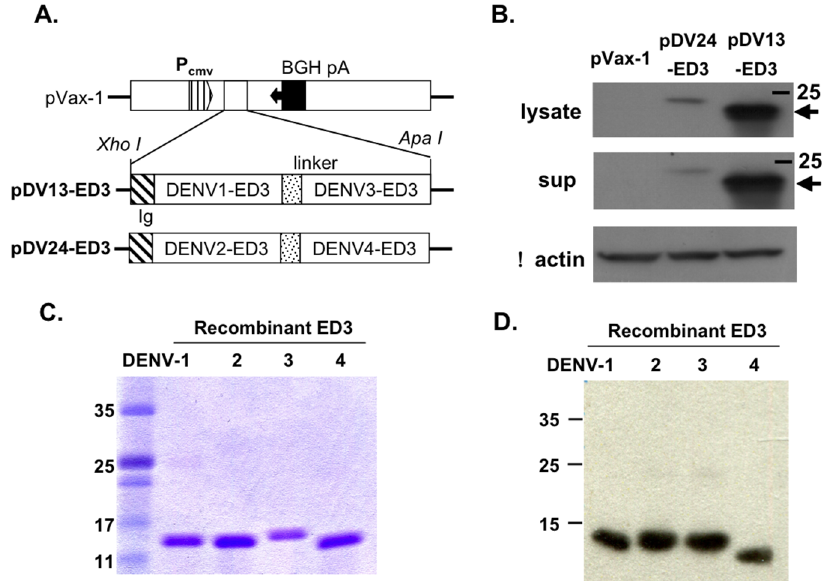
Fig 1. Preparation of a tetravalent ED3-expressing DNA vaccine and a tetravalent recombinant ED3 protein vaccine. (A) Schematic diagram of two ED3-expressing plasmids, pDV13-ED3 and pDV24-ED3, generated by cloning DNA fragments consisting of tandem repeats of ED3 from DENV-1 and 3, and DENV-2 and 4 into the pVax-1 vector between the Xho I and Apa I sites. The positions of the immunoglobulin light chain signal peptide (Ig) or three repeats of GGGGS linker (linker) are also indicated. (B) The presence of bivalent ED3 in the culture supernatants or cell lysates of 293Trex cells transfected with pVax-1, pDV13-ED3 or pDV24-ED3 for 24 h was detected with an ED3-specific monoclonal antibody. The expression of β -actin cellular protein in the cell lysate was used as a control. The recombinant ED3 proteins from DENV-1 to 4 were expressed in E . coli and purified with an affinity column. The final products were analyzed by SDS-PAGE (C) or Western blotting (D) with hyperimmune